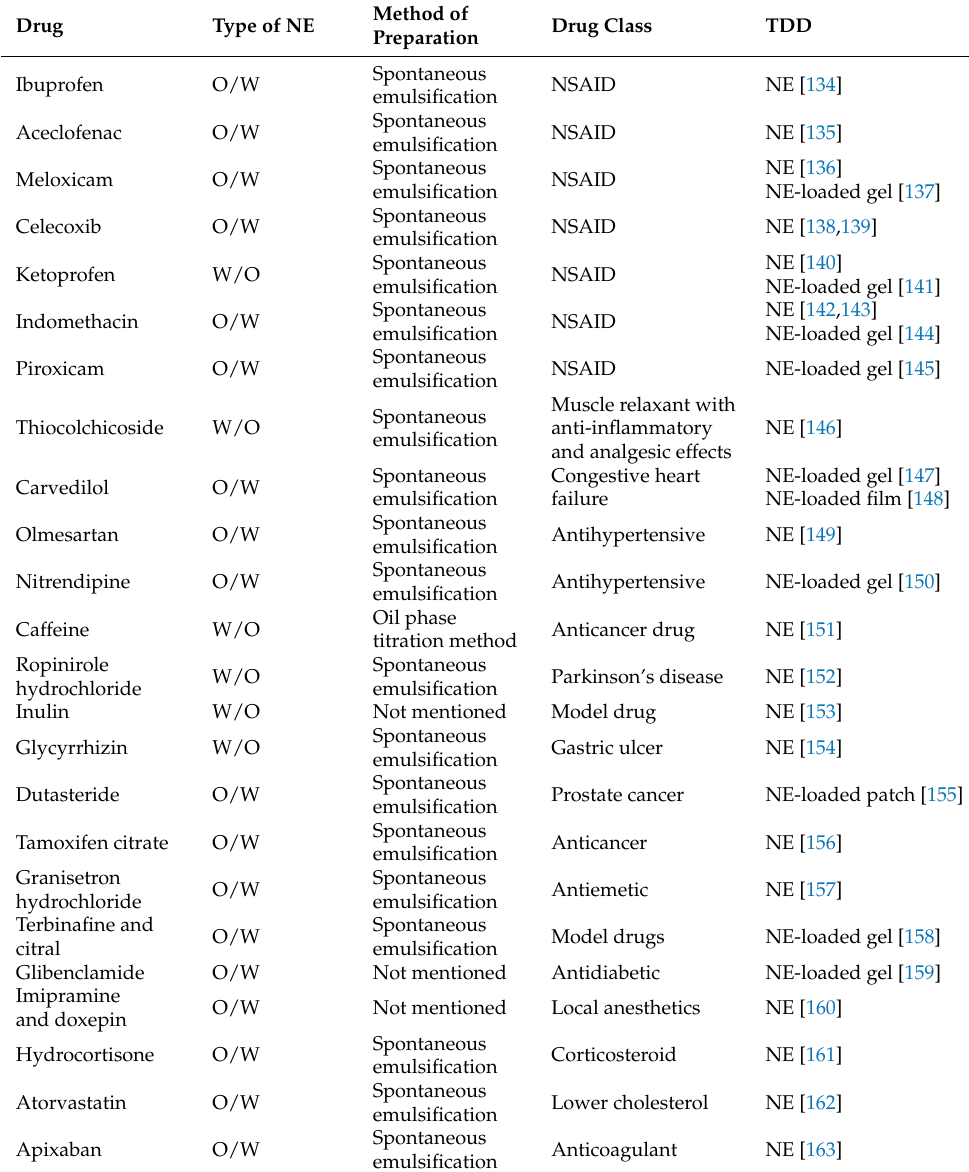
Table 2. Drugs loaded into NEs, the types of NEs, the method of NE preparation, drug class, and the transdermal delivery